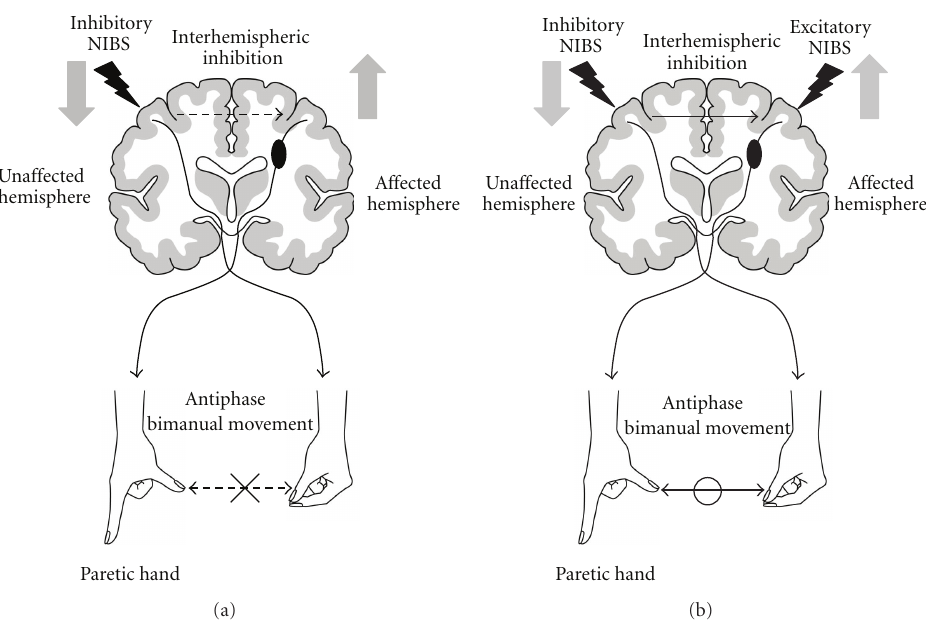
Figure 2: Mechanism and prevention of bimanual movement deterioration by NIBS in stroke patients. (a) Inhibitory NIBS over the una ff ected hemisphere. Inhibitory NIBS decreases excitability of the contralesional motor cortex and increases excitability of the ipsilesional motor cortex by reducing interhemispheric inhibition from the una ff ected to the a ff ected hemisphere. Antiphase bimanual movement deteriorates due to the reduction in interhemispheric inhibition, which controls bimanual movement. (b) Bilateral NIBS. Excitatory NIBS, along with inhibitory NIBS, decreases excitability of the contralesional motor cortex and increases excitability of the ipsilesional motor cortex. However, bilateral NIBS limits the reduction in interhemispheric inhibition induced by inhibitory NIBS and prevents antiphase bimanual movement deterioration. Modified from Takeuchi et al.